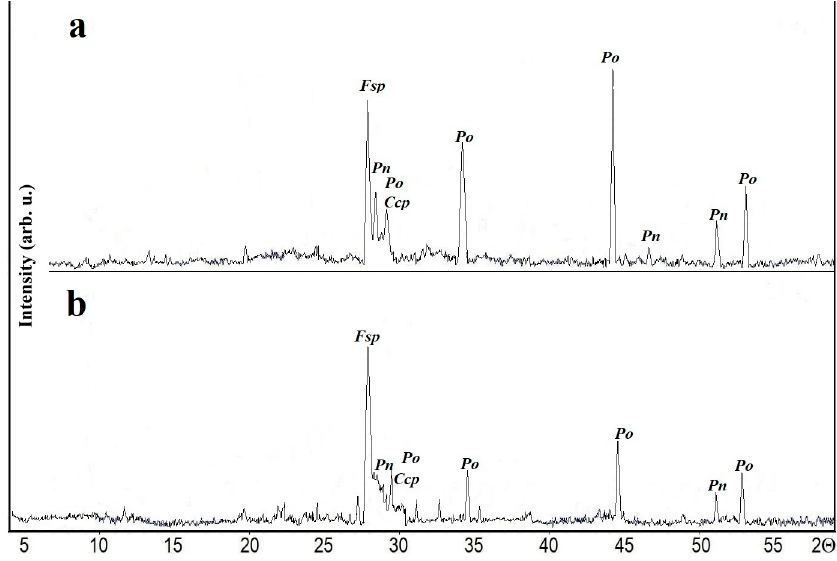
Figure 4. X-ray diffraction pattern of the Nud II samples: ( a ) feed ore; ( b ) ore after leaching. Fsp: feldspar; Po: pyrrhotite; Pn: pentlandite; Ccp: chalcopyrite. The pH value of the pregnant liquors varied from 1.8 to 2.3, while the redox potential ranged from 488 to 608 mV. The concentration of ferric iron, which at the beginning of the experiment was 9 g/L, increased by the end of the experiment to 16.4 g/L, while the concentration of ferrous iron decreased from 1.9 g/L to 0.9 g/L. The sulfur content in the solid phase decreased by 34.6%, which is three times higher than in the Allarechensk TD ore (Table 2). Table 2. Chemical composition of the Nud II ore.